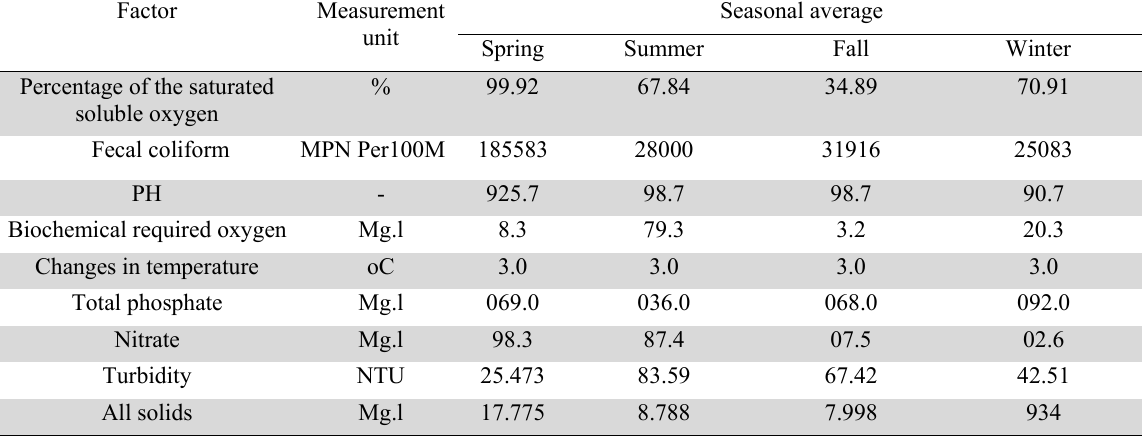
Mean of quality values of measured WQI parameters of Cesar river stations factor